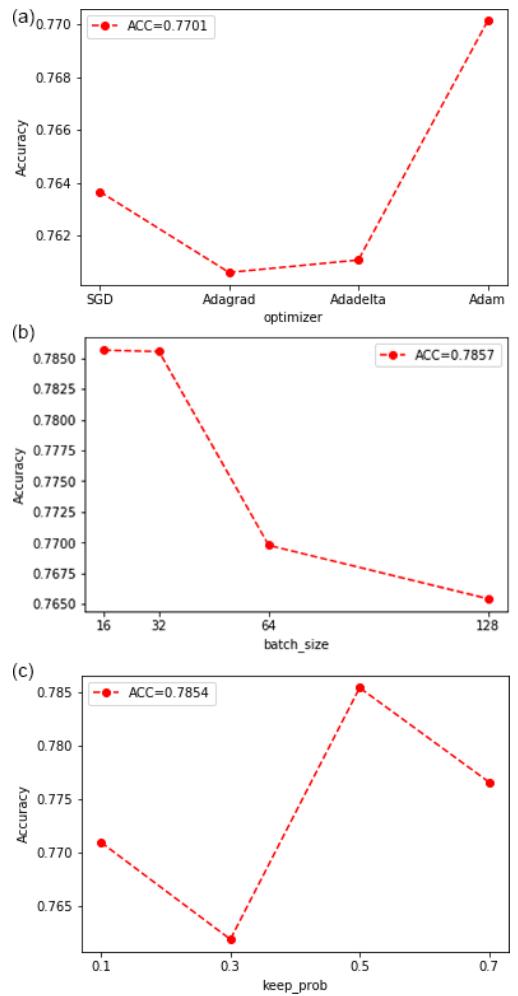
Figure 5. Hyperparameter selection based on grid search: optimiza- tion function selection image (a) , batch_size selection image (b) , keep_probs selection image (c)